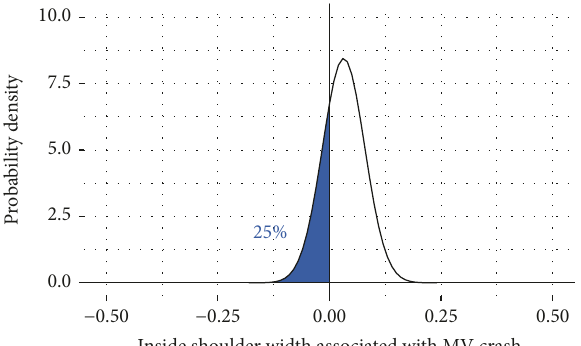
Figure 2: Distribution of insider shoulder width associated with MV crash.